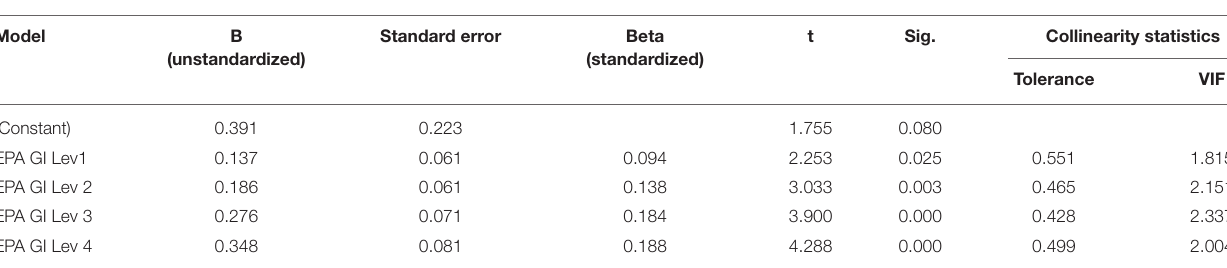
TABLE 4 | OLS regression for GI EPA 4 a .